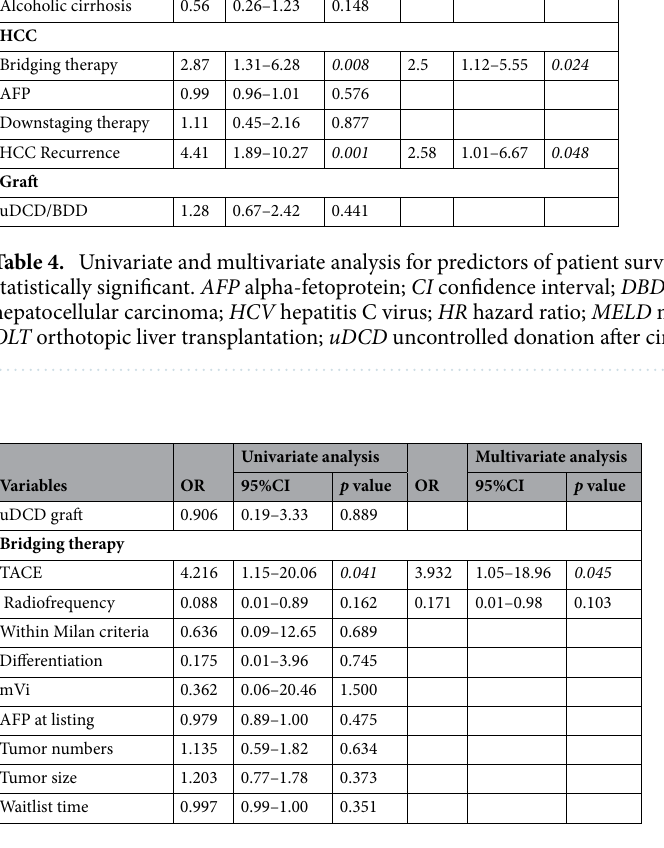
Table 5. Univariate and multivariate analysis for predictors of hepatocellular recurrence after transplantation. Italic values indicate statistically significant. AFP alpha-fetoprotein; CI confidence interval; mVi microvascular invasion; OR odds ratio; TACE transarterial chemoembolization; uDCD uncontrolled donation after circulatory death.